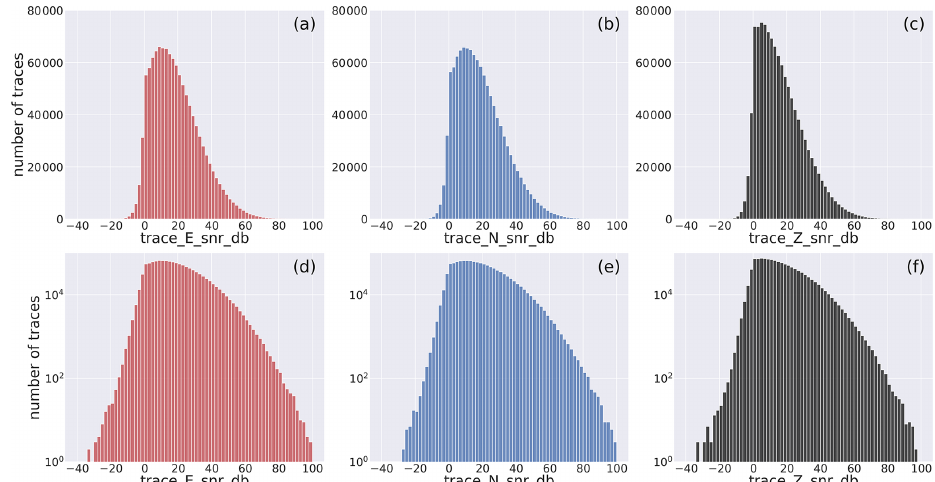
Figure 10. Distribution of the signal-to-noise ratio of the earthquake E -, N -, and Z -component waveform traces. The panels (a) – (c) have linear y axes, whereas those on the bottom are in logarithmic scale. The horizontal axis labels correspond to the metadata being represented which are listed in Table